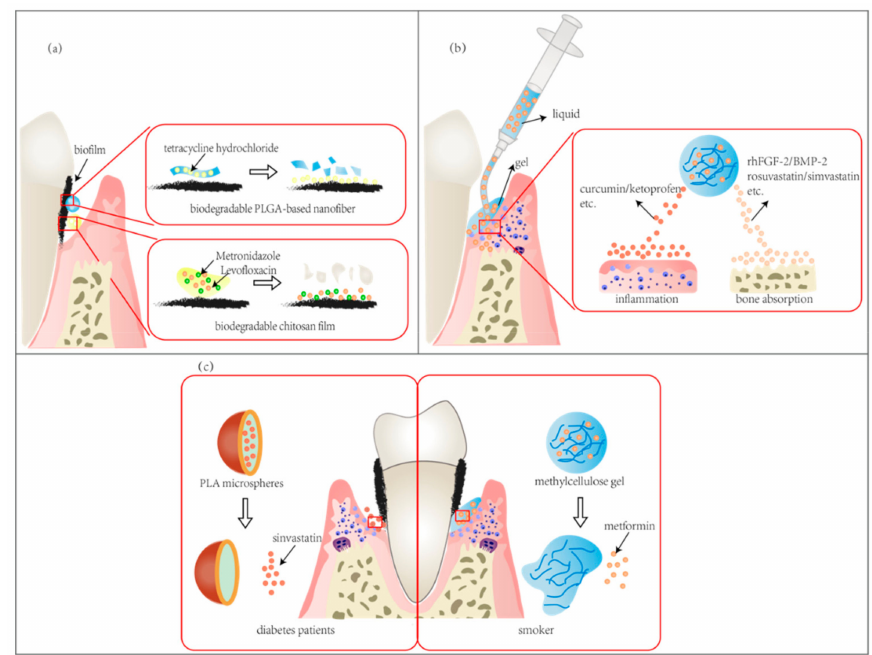
Figure 5. DDS used in periodontitis. ( a ) antimicrobial agents loaded DDS. Various antibiotics